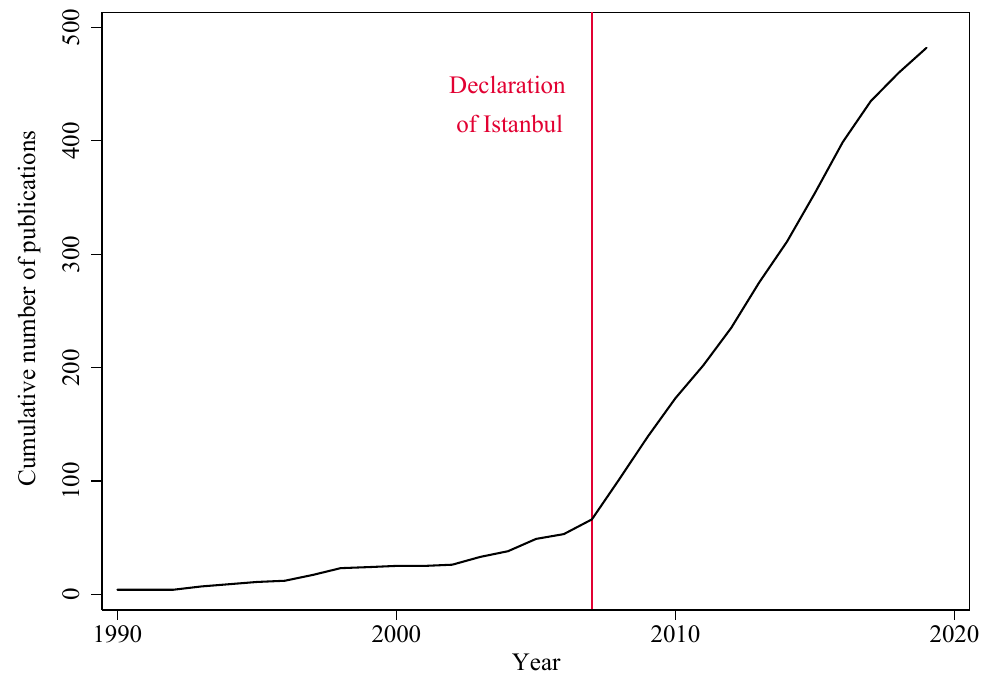
Figure 1. Total number of publications on THBOR per year.